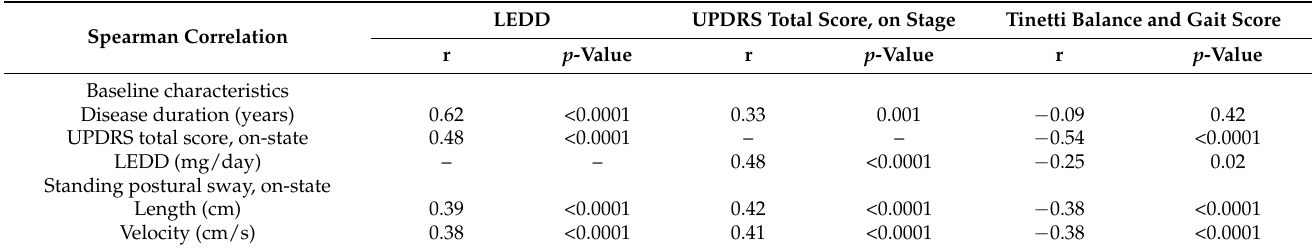
Table 4. Partial correlation analysis among parameters of standing postural sway, LEDD and UPDRS total score, and Tinetti balance and gait score after controlling with the moment of inertia. LEDD UPDRS Total Score, on Stage Tinetti Balance and Gait Spearman Correlation